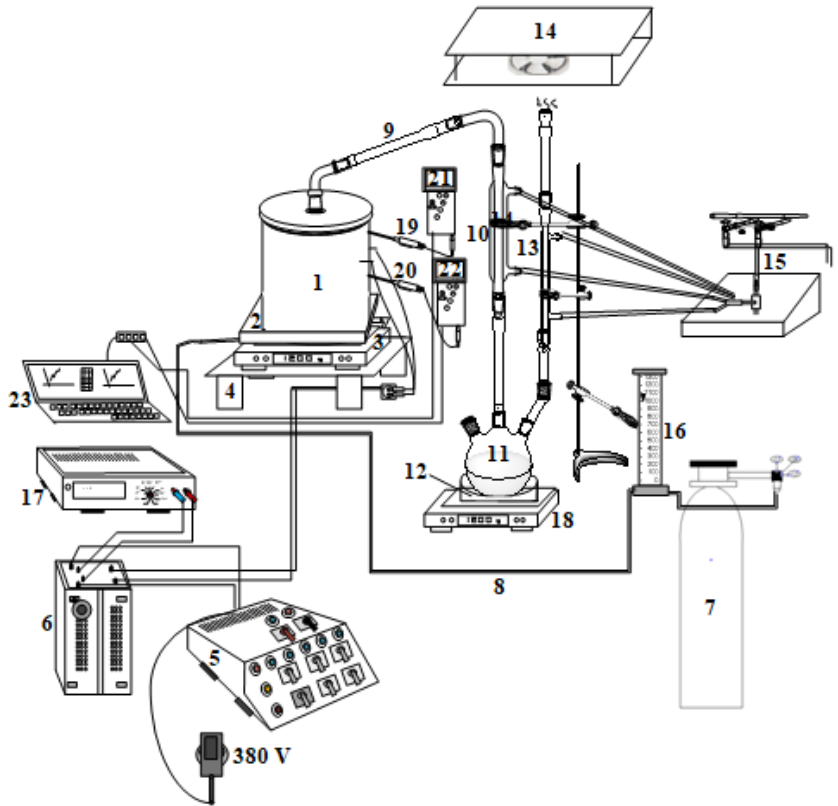
Figure 2. Experimental setup: ( 1 ) pyrolysis reactor; ( 2 ) ACC support; ( 3 ) precision balance (max. 30 kg); ( 4 ) metal support; ( 5 ), ( 6 ) power transformers; ( 7 ) gas tank; ( 8 ) sweeping gas feed pipe; ( 9 ) pipe collecting volatile products; ( 10 ), ( 13 ) double pipe heat exchangers; ( 11 ) oil collector; ( 12 ) PU support; ( 14 ) exhaust hood; ( 15 ) coolant supply/discharge system; ( 16 ) flow meter; ( 17 ) voltmeter; ( 18 ) precision balance (max. 10 kg); ( 19 ), ( 20 ) thermocouples; ( 21 ), ( 22 ) thermometers; ( 23 ) data recording and processing system.